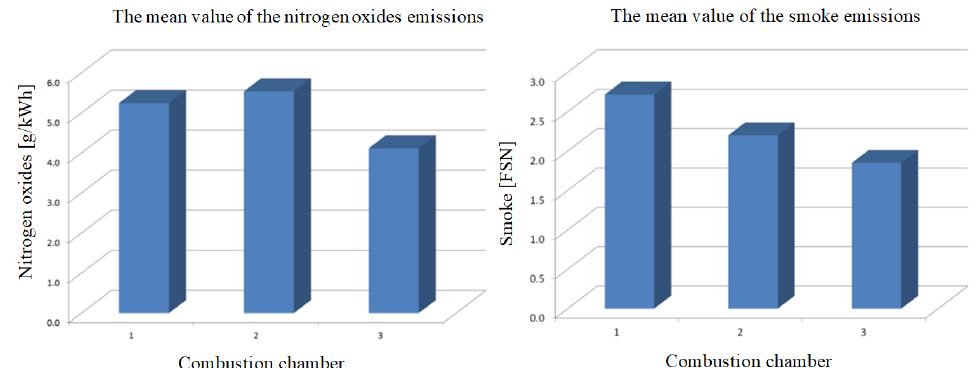
Figure 33. Comparison between the mean nitrogen oxides and smoke emissions for the three com- bustion